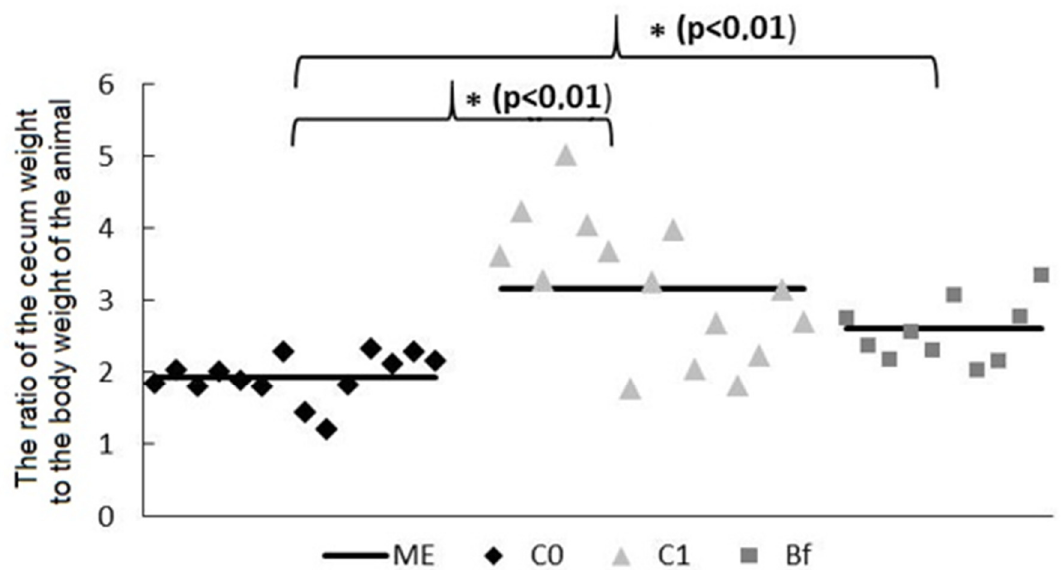
Figure 3. Changes in the ratio of the cecum weight (including to its contents) to the body weight of animal in a rat model of antibiotic-associated dysbiosis. The rat groups: C0 (control)—without the introduction of antibiotics and autoprobiotics, C1—without the introduction of autoprobiotics after the withdrawal of antibiotics, and Bf—with the introduction of indigenous bifidobacteria after the withdrawal of antibiotics. ME—median. Mann–Whitney U test, * p <